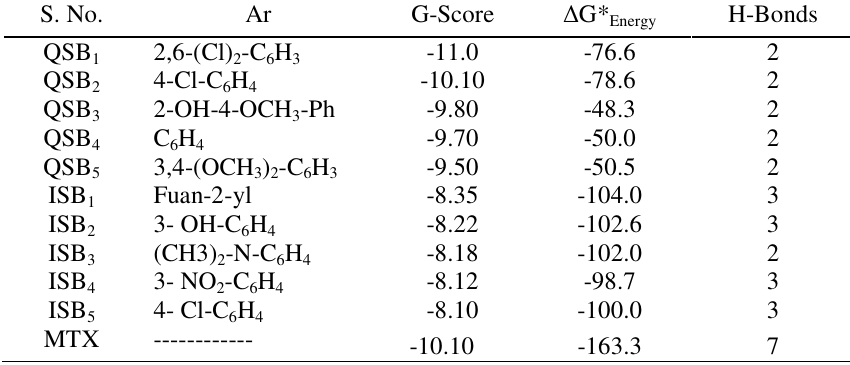
Table 1. G-Scores and ∆ G binding energy